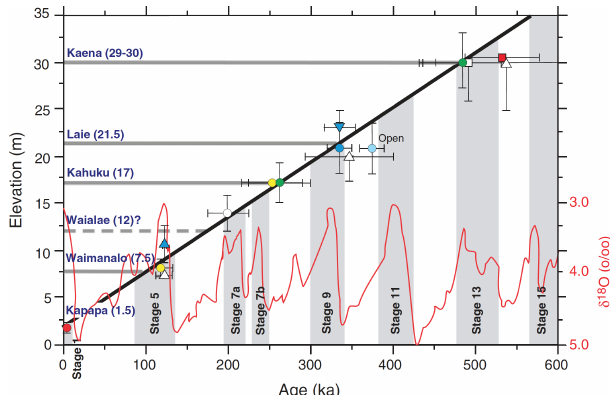
Figure 34. Mean or best ages versus maximum measured terrace elevation for known elevated reefs on Oahu (from McMurtry et al.,